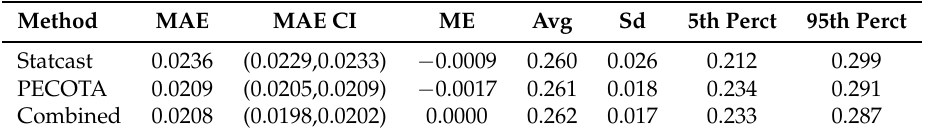
Table 1. Comparison of the three prediction methods in 2017. We include mean absolute error (MAE), 95% CI for MAE based on 100 bootstrap samples, ME (mean error), average prediction, standard deviation of the prediction and prediction